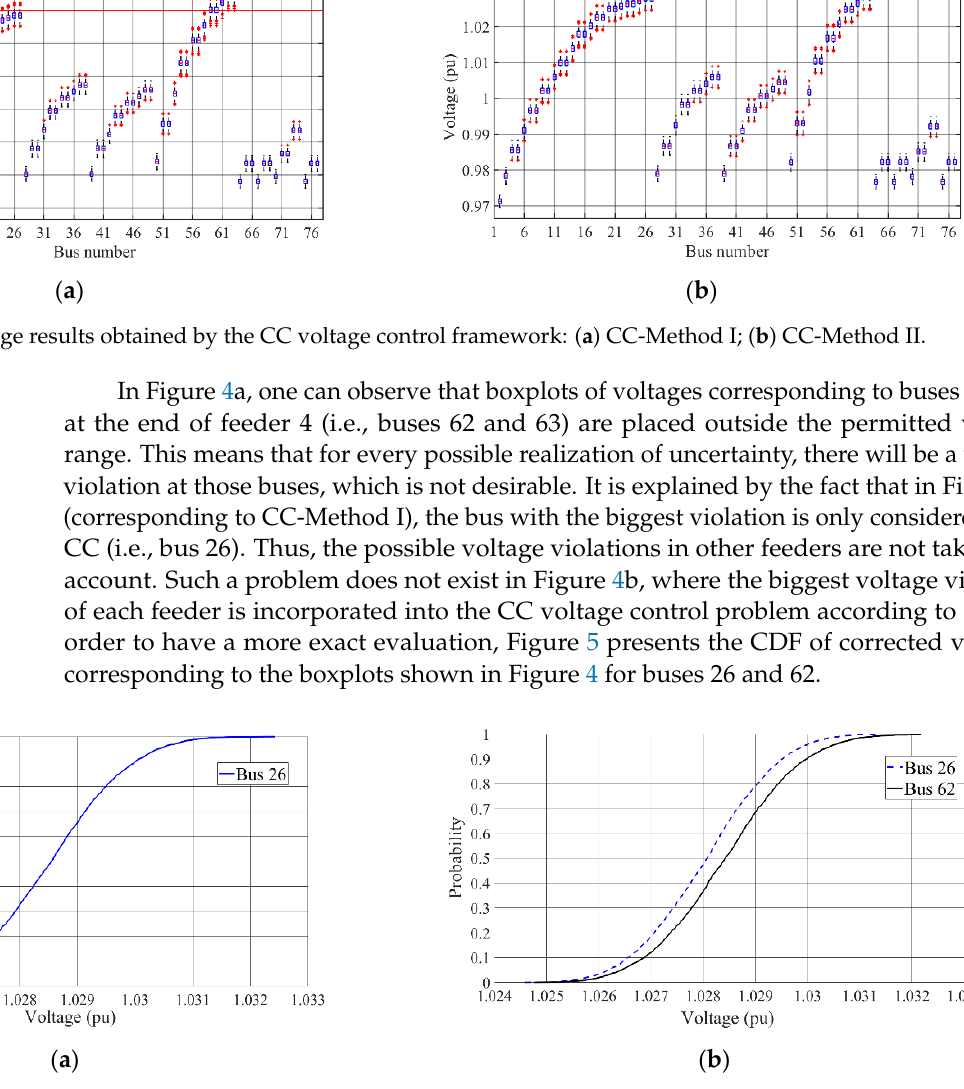
In the second part of this section, we evaluate here the performance of the proposed